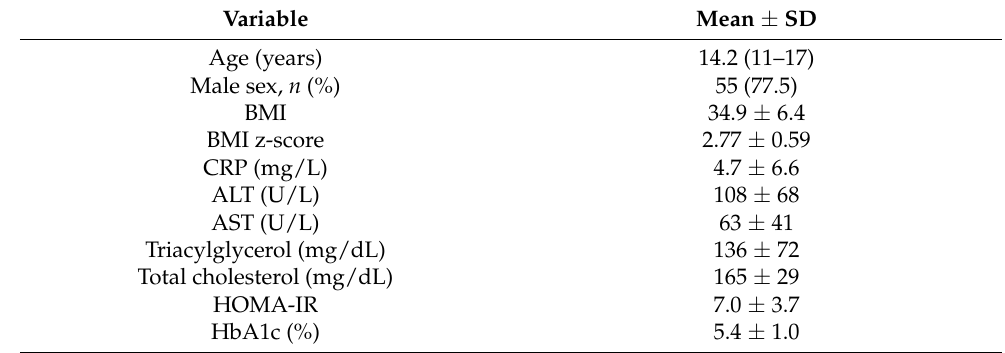
Table 1. Selected clinical parameters highlighting general features of NAFLD in the study group. Values are expressed as mean ± SD unless indicated otherwise. SD = standard deviation; BMI = body mass index; BMI z-score = body mass index standard deviation score adjusted for age and sex; CRP = C-reactive protein; ALT = alanine aminotransferase; AST = aspartate aminotransferase; HOMA-IR = homeostatic model assessment for insulin resistance; HbA1c = hemoglobin A1c. Variable